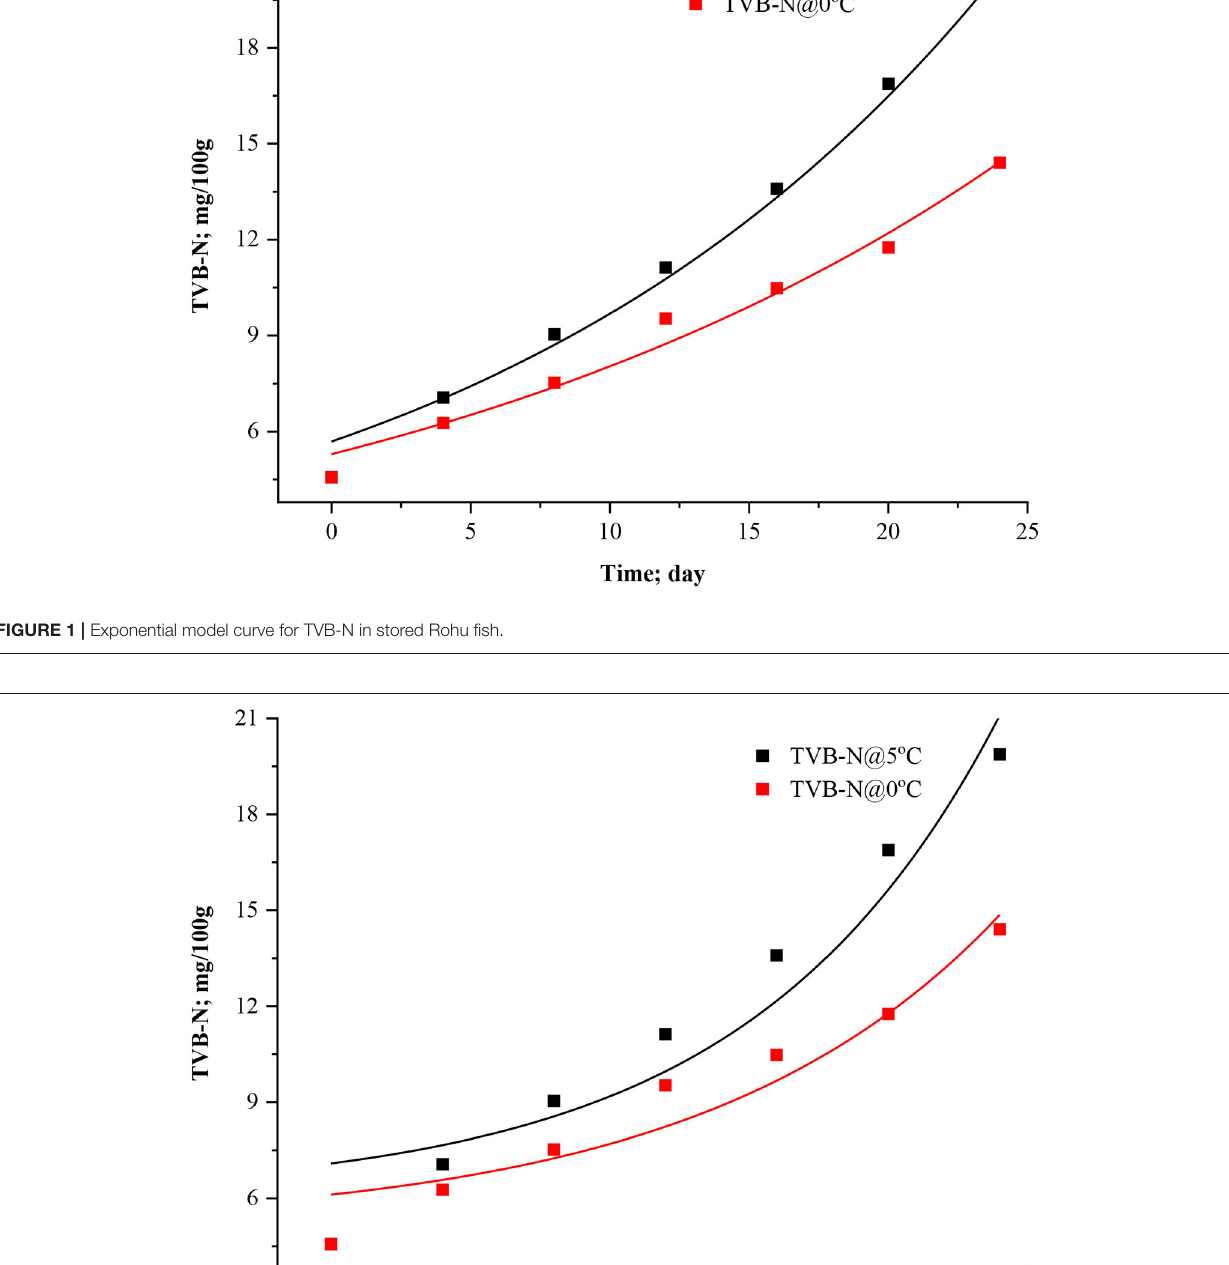
exponentially even under the advanced spoilage phase (Howgate, 2010b; Heising et al., 2014b). This equation only uses for the initial phase of volatile formation. For minimum and